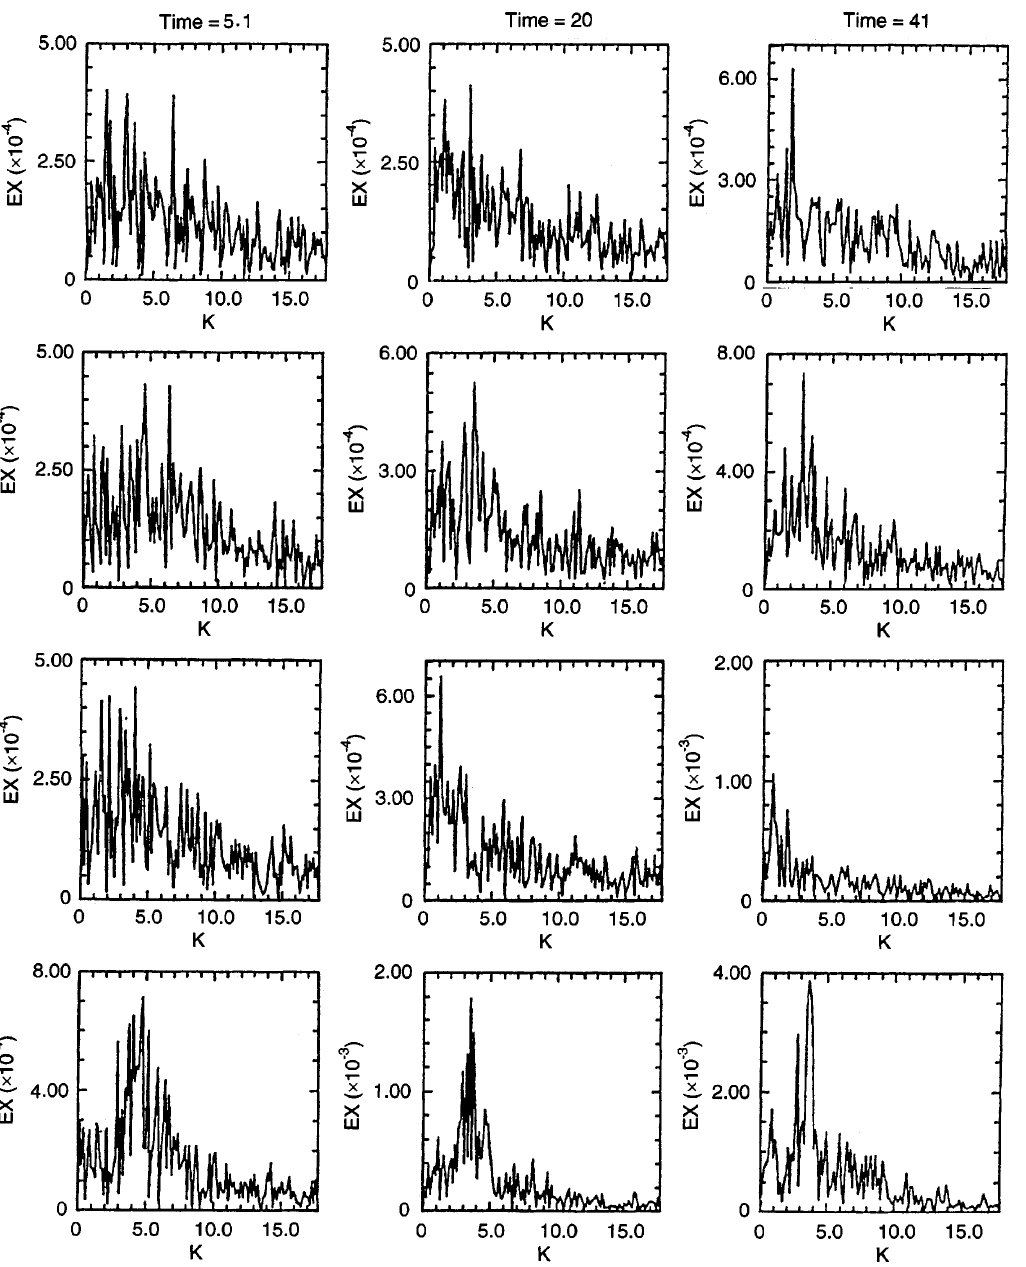
Fig. 5. Wavenumber spectra of the electric field at t (cid:136) 5 : 1 ( left panel ), t (cid:136) 20 ( middle panel ), and t (cid:136) 41 ( right panel ). Normalizations and runs as defined in